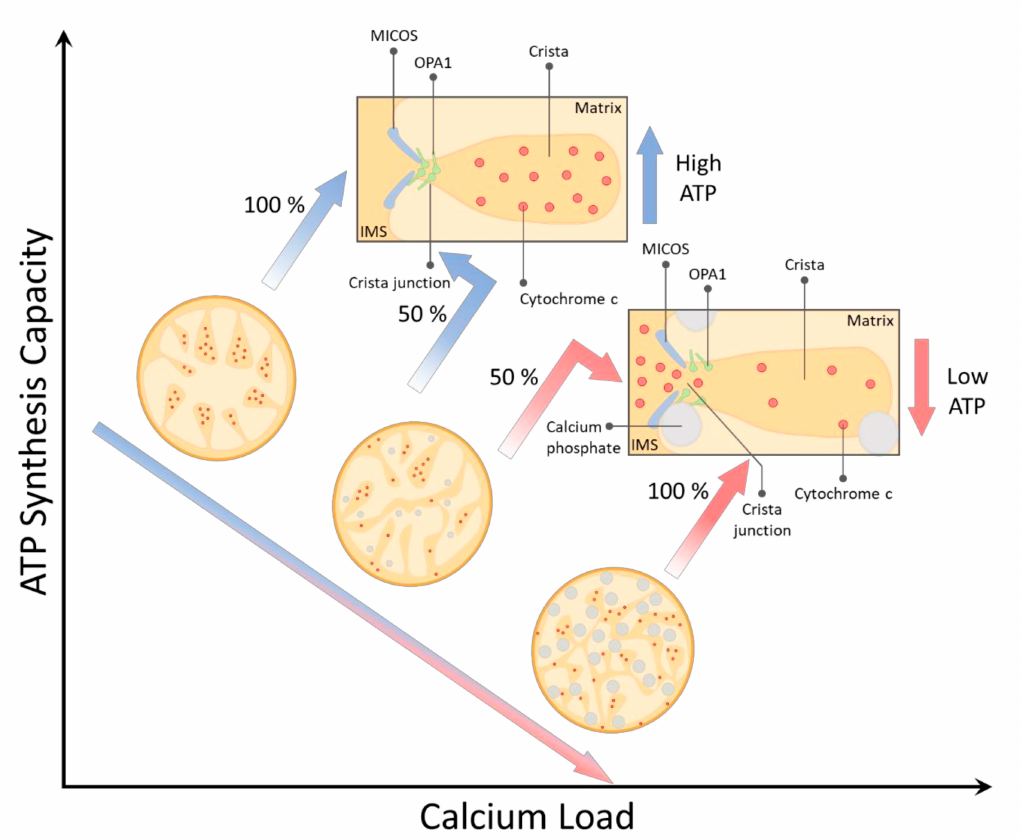
Figure 9. Model of calcium overload-induced mitochondrial dysfunction. We hypothesize that a calcium overload causes cristae remodeling, redistributes cytochrome c, and lowers the ATP synthesis capacity in a manner that is proportional to the calcium